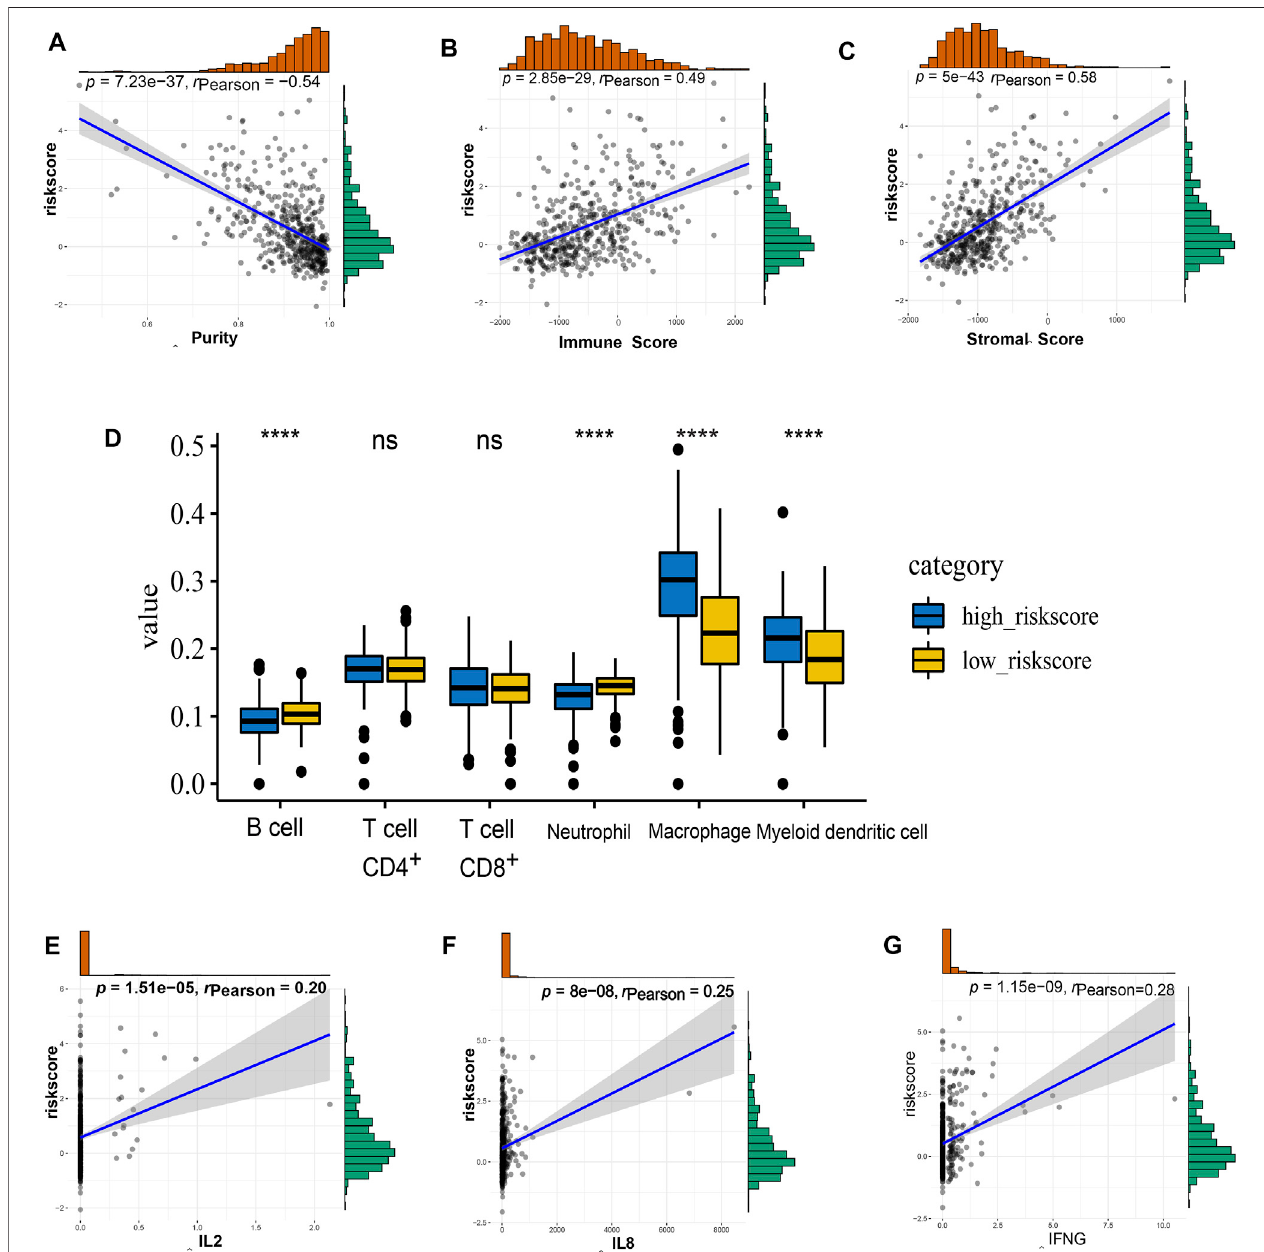
FIGURE6| Theimmunelandscapeofnectin-based signatureinTCGA LGG samples. (A – C) Thecorrelationofriskscorelevel withtumor purity (A) , immune score (B) ,and stromalscore (C) . (D) Thedetailsofdifferentexpressionimmunecellsinhigh- andlow-risk groupsi. (E – G) Thecorrelation ofriskscorelevelwiththeexpression of IL2 (E) , IL8 (F) , and IFNG (G)